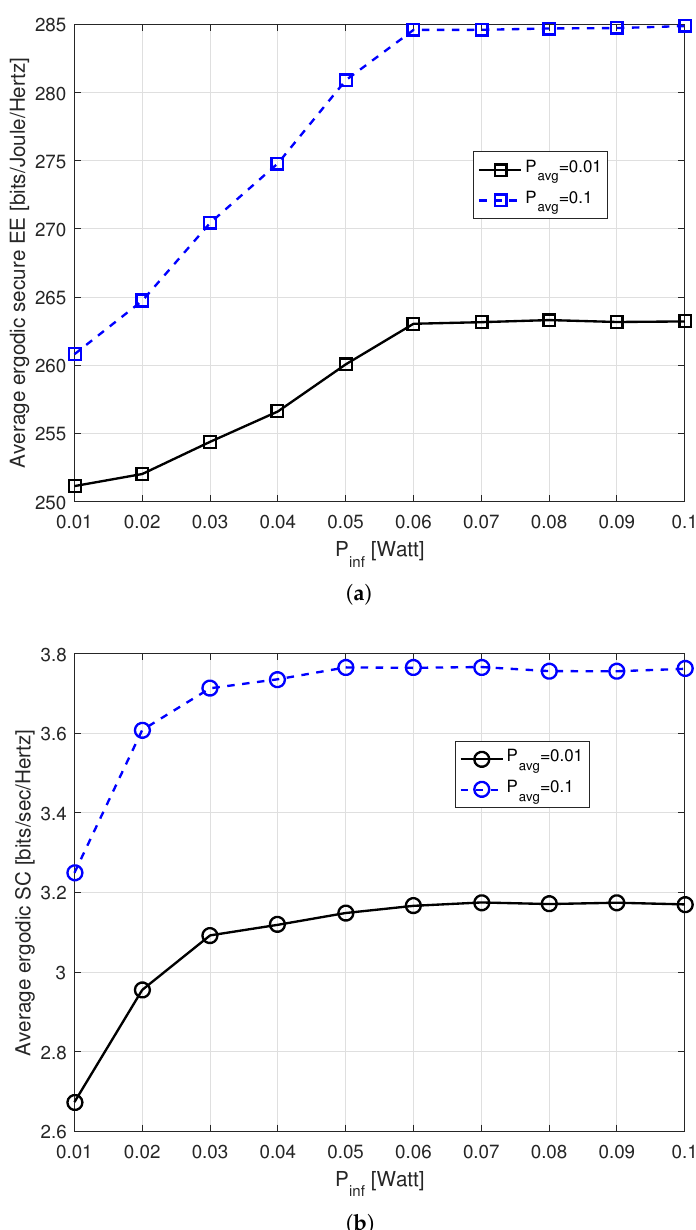
Figure 5. Average ergodic secure EE and SC of SU versus P inf . ( a ) Average ergodic secure EE of SU versus P inf , ( b ) Average ergodic secure EE and SC of SU versus P inf